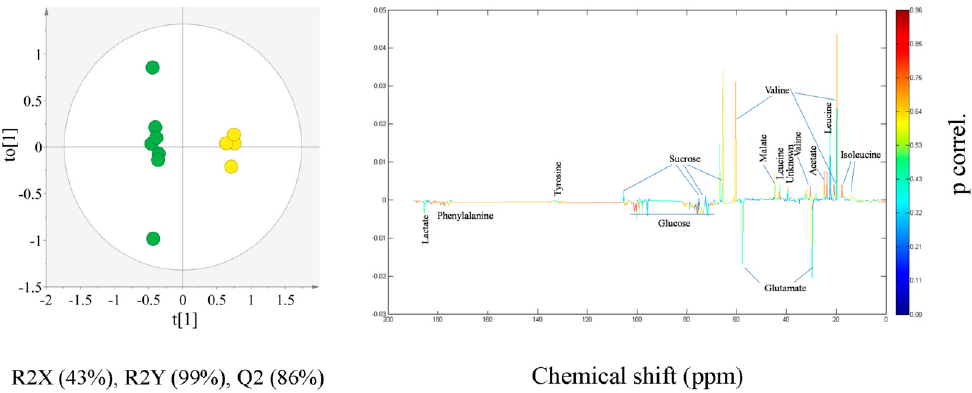
Figure 5. OPLS-DA score scatter plot derived from 13 C-NMR spectra of Chinese red cooking (green circle) and Taiwan super light (yellow circle) soy sauce and the color-coded loading line plot generated from the OPLS-DA model representing the metabolites responsible for discrimination among Chinese red cooking and Taiwan super light soy sauce .